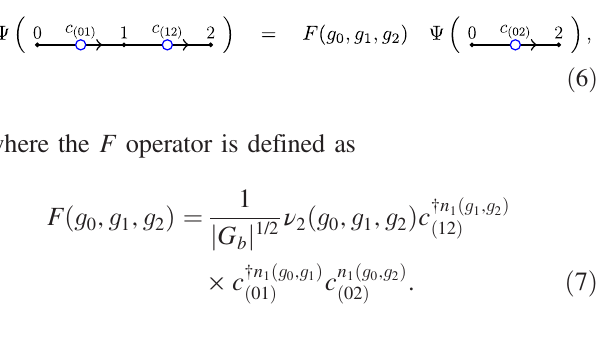
FIG. 1. Bosonic and fermionic degrees of freedom for 1D fixed- point FSPT states on a link. The black dots are bosonic degrees of ∈ G on sites. The blue ball represents the freedom labeled by g i complex fermion c at the center of the link h ij i . The arrow ð ij Þ represents the local order of two